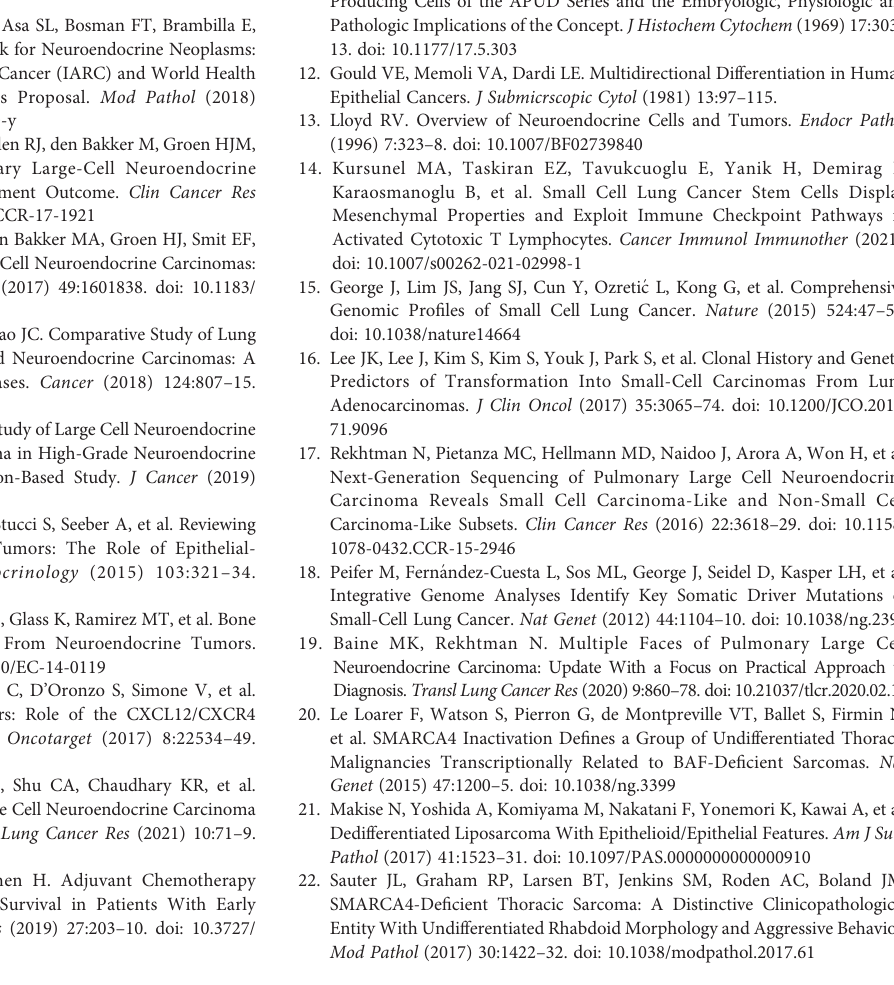
Supplementary Figure 4 | Box plot of the associations between EMT gene expressionanddistantmetastasis(absence vs presence)inalogscale.Thetopand bottom of the box plot represents the 25th and 75th percentile range. The line across the box shows the median of gene expression and the top and bottom bars show the maximum and minimum values, outliers were showed. The association between EMT gene expression and distant metastasis was calculated by Fisher ’ s exact test. (A) COL3A1 mRNA (P=0.013) and (B) COL5A2 mRNA